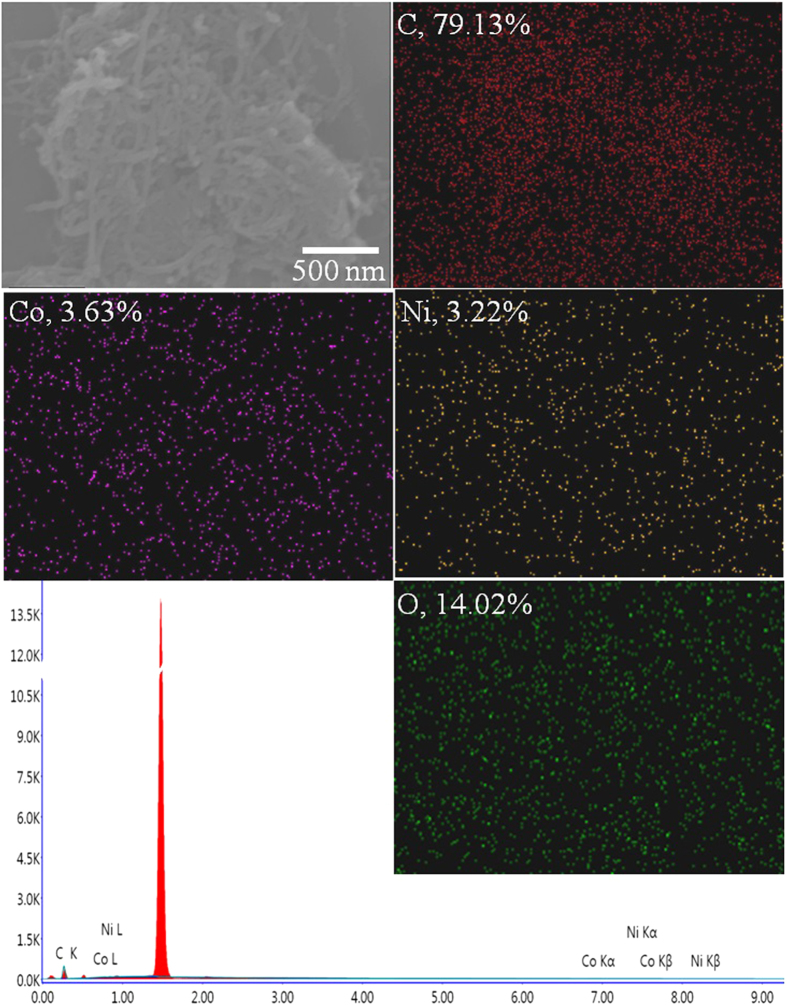
FE-SEM/EDS spectrum and mapping of NiCo2O4/MWCNT.